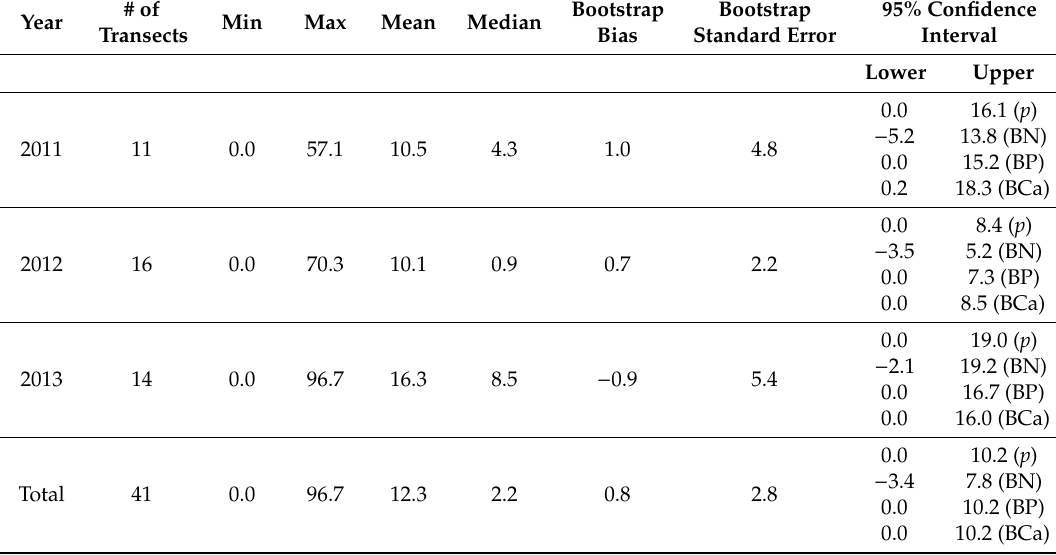
Table 2. Summary statistics of carbon loss by year in mining damaged trees, in Mg C ha − 1 in 41 transects. The “year” column indicates the period of mapping during which mining activities were identified by Guyana Forestry Commission mapping (2011–2013). The uncertainty range at 95% confidence interval was estimated using percentile method ( p ), bootstrap normal method (BN), bootstrap percentile method (BP), and bootstrap bias-corrected and accelerated method (BCa), respectively. The bootstrapped values were derived from the resampling through 10,000 iterations.